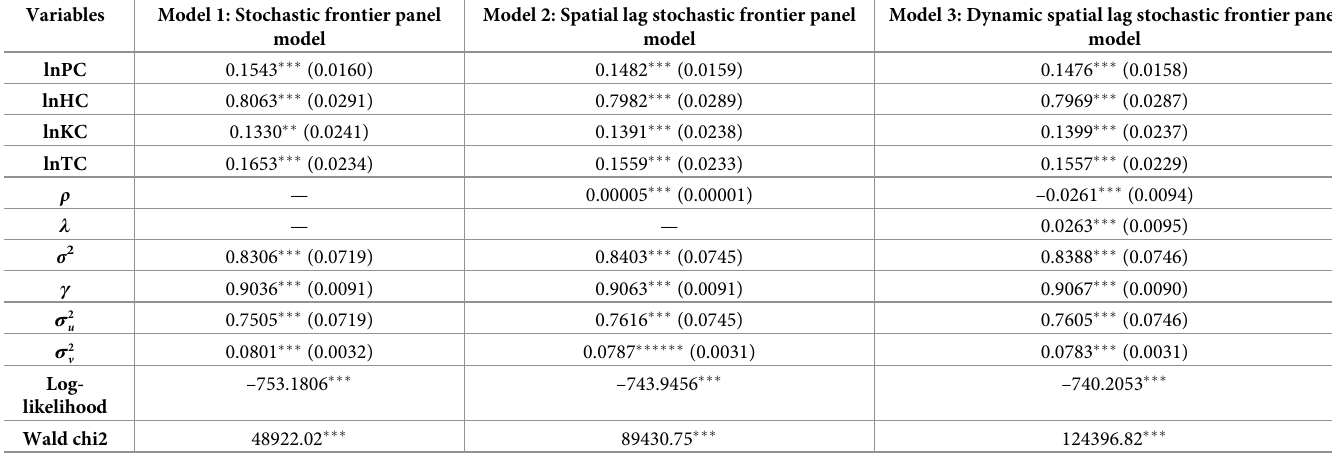
Table 4. Estimation results of the